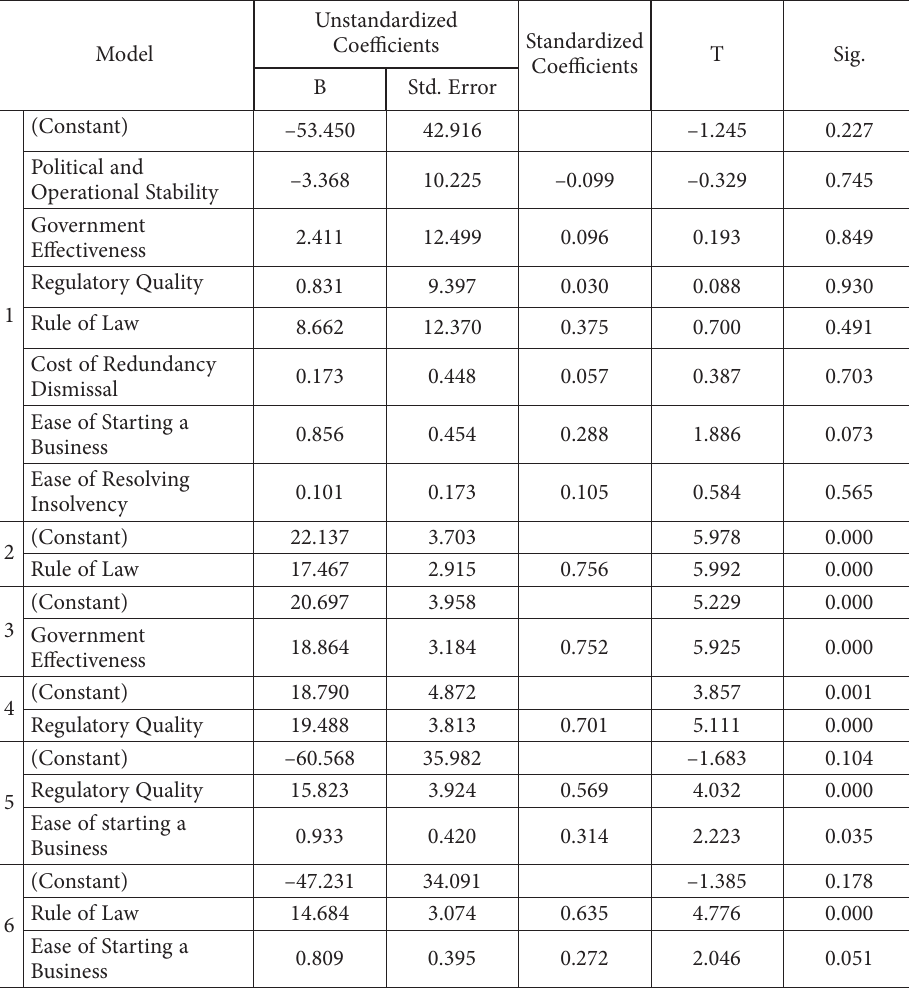
Table 4. Regression coefficients